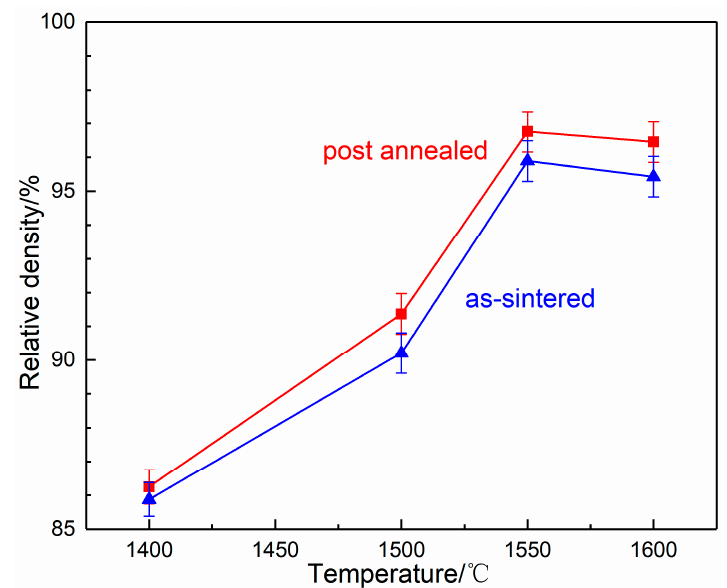
Figure 9. Relative density of 0.9 Al 2 O 3 -0.1 TiO 2 ceramics sintered at different sintering temperatures and annealed at 1000 °C for 5 h. Electronics 2019 , 8 , 1067 12 of 15